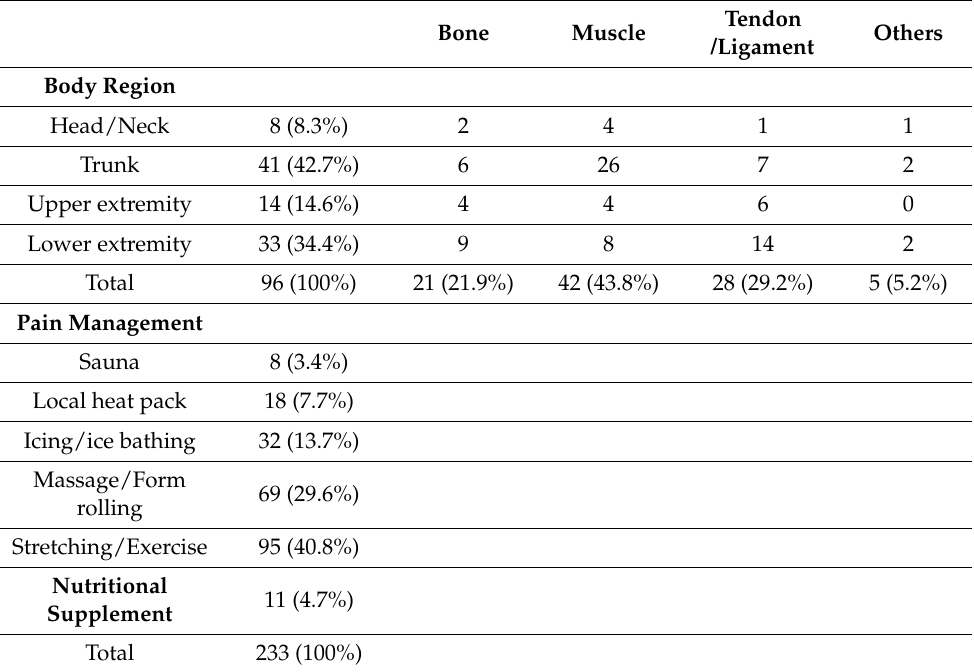
Table 6. Distribution of chronic pain and pain